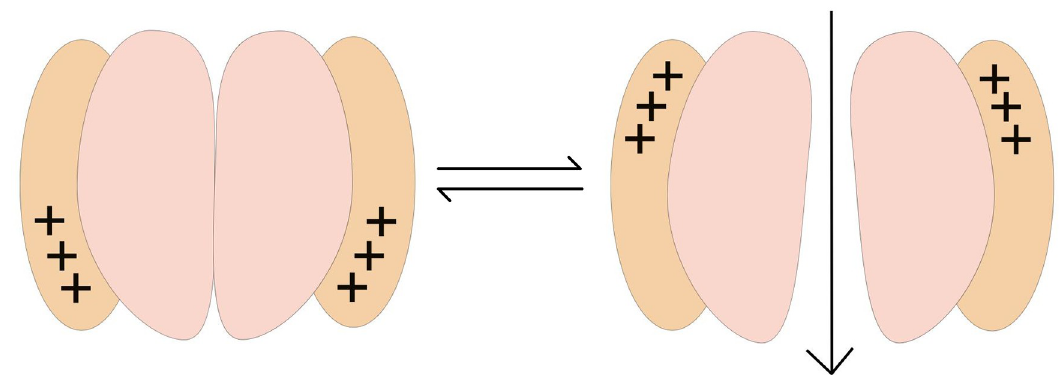
Fig 1. Two-state toy model of a Kv channel. The upwards movement of gating charges (in black) generates a gating current that induces the conformational change from a closed to an open state (voltage sensor domains in orange).